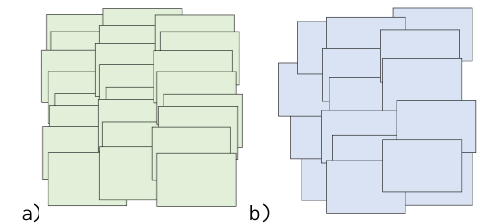
Figure 1. Example of UAV flight patterns: strip/grid-based image block (a) and irregular overlap (b).